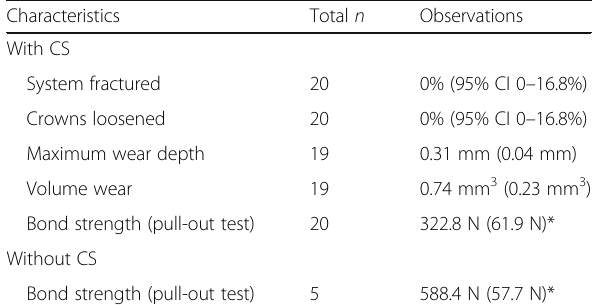
Table 4 Characteristics of polymer-infiltrated ceramic crowns on one-piece zirconia